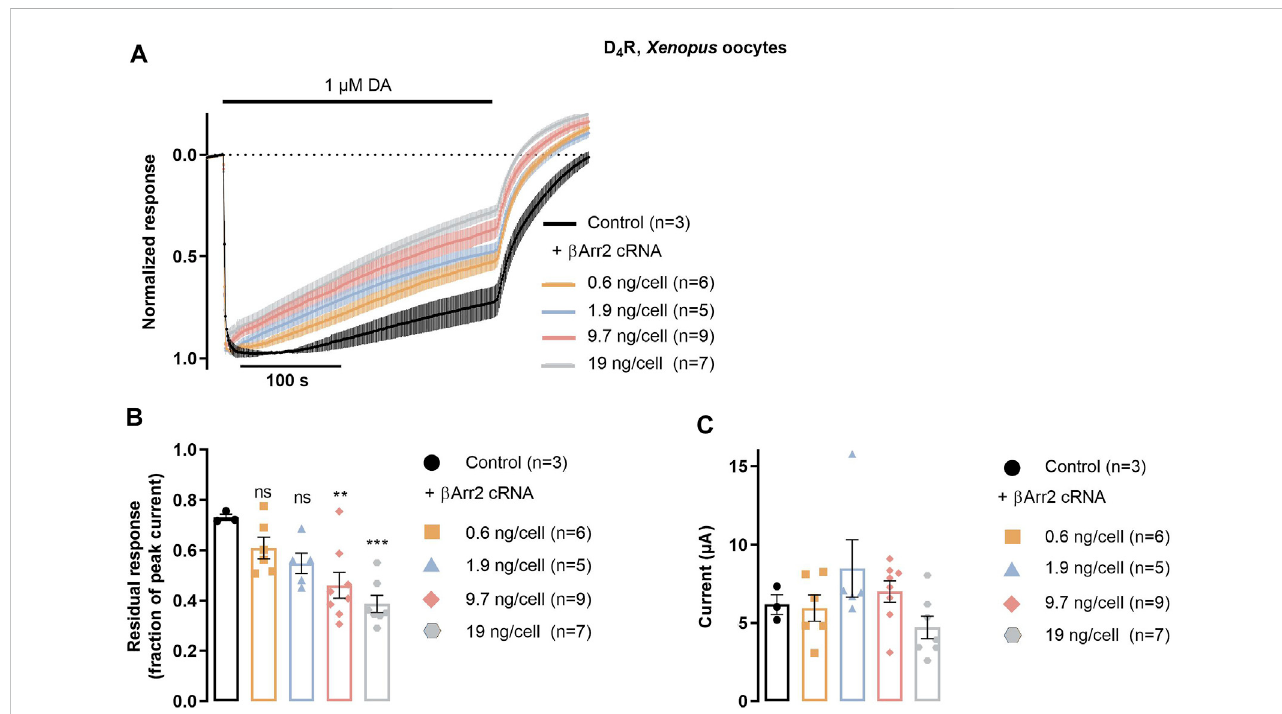
FIGURE 3 β arr2-induced desensitization of D Xenopus oocytes. Oocytes were injected with D 4 R in 4 R cRNA together with RGS4 and GIRK1/4 channel subunit cRNAs, in addition to variable amounts of β arr2 cRNA, as indicated. (A) Peak-normalized and averaged traces of GIRK currents evoked by 1 μ M dopamine in oocytes co-injected with varying amounts of β arr2 cRNA. (B) D 4 R desensitization rate expressed as residual GIRK response (fraction of initial peak response) after 415 s application of 1 µM dopamine. Data from the experiments shown in (A) Asterisks denote statistically signi fi cant effects of GRK2 coexpression vs control. ***; p < 0.001, **; p = 0.004, n.s.; not signi fi cant, one-way ANOVA with Dunnett ’ s test for multiple comparisons. (C) Peak amplitudes of GIRK current responses shown in (A) Data points represent mean ± SEM from three to nine oocytes, as indicated. Superimposed symbols in bar graphs